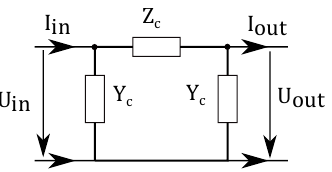
Figure 13. Π -section model of submarine